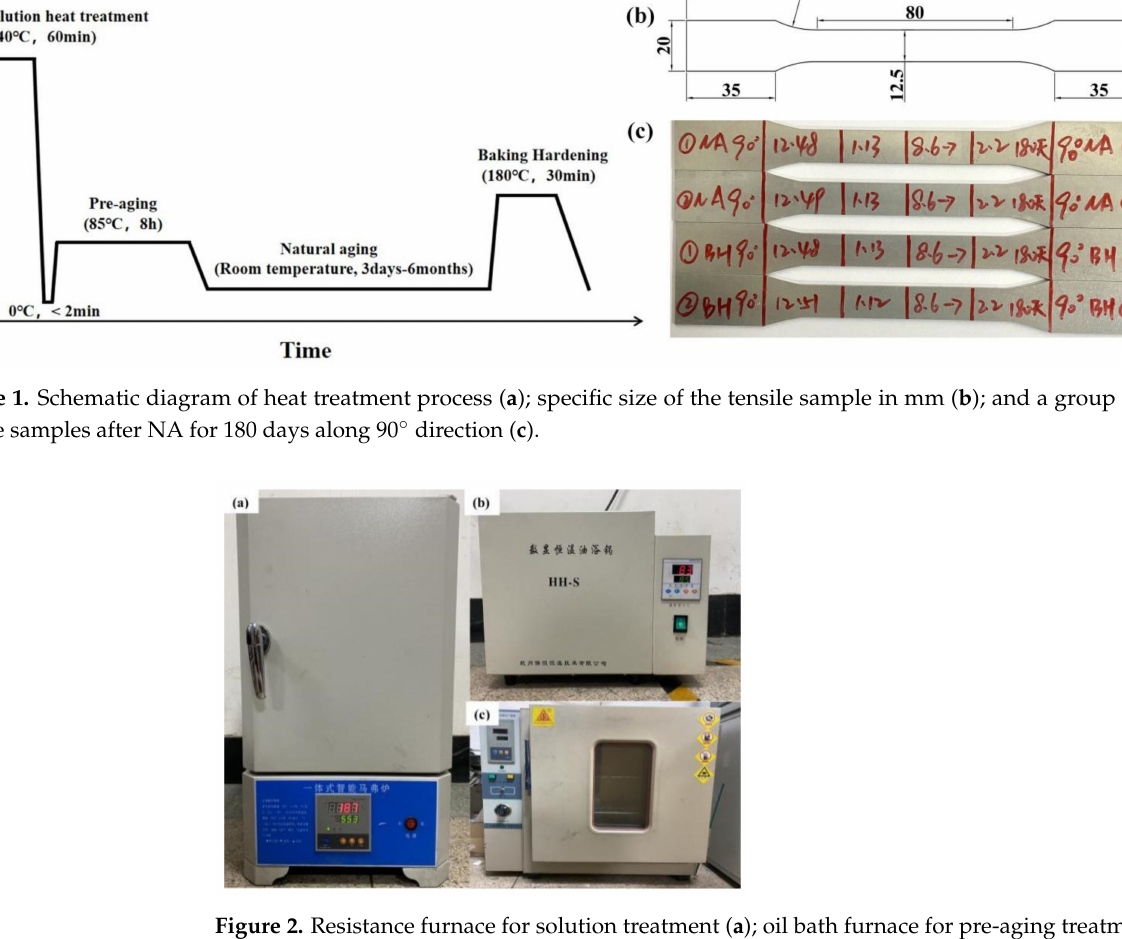
Figure 2. Resistance furnace for solution treatment ( a ); oil bath furnace for pre-aging treatment ( b ); and 101A-18T electric heating drying oven for baking hardening ( c